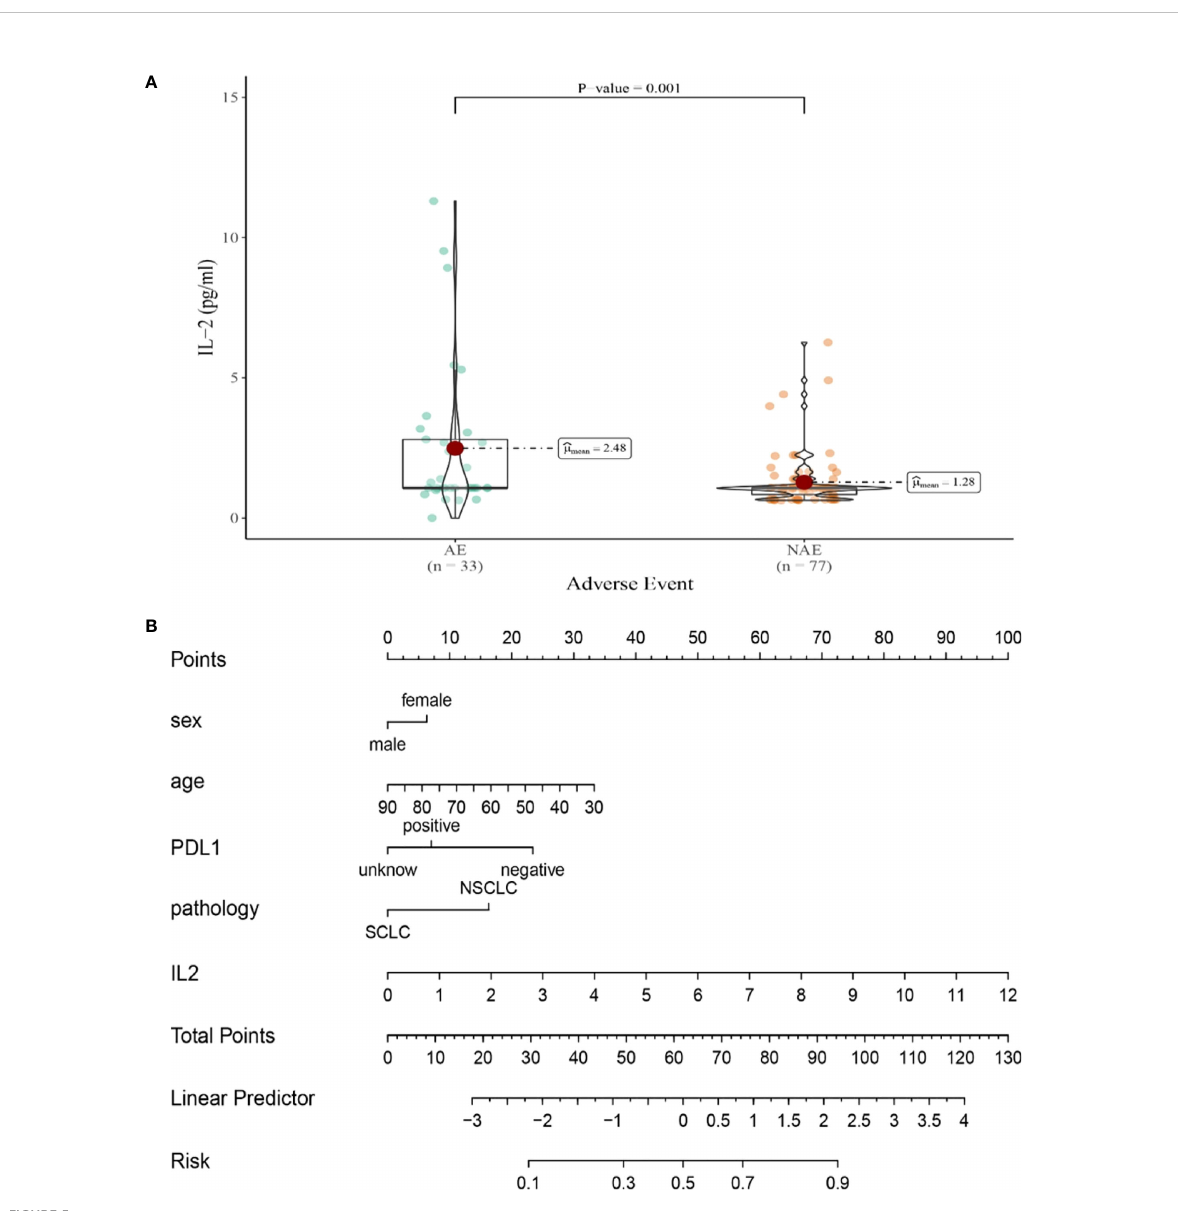
FIGURE 5 (A) Differences in baseline IL-2 levels between AE and NAE; (B) The nomogram of irAEs prediction based on logistic multivariate